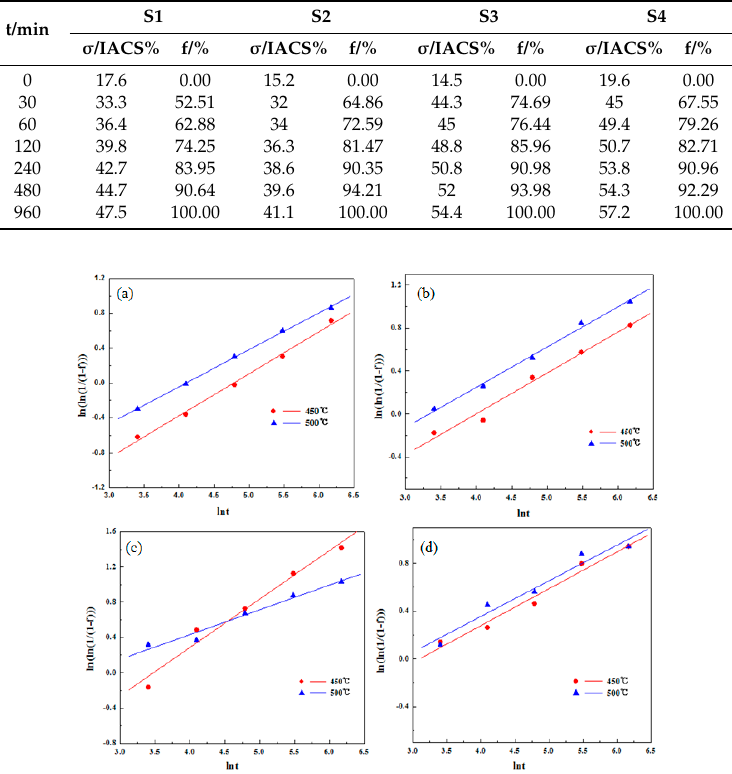
Figure 8. The relation between volume fraction and transformation time ( a ) S1 alloy. ( b ) S2 alloy. ( c ) S3 alloy. ( d ) S4 alloy.